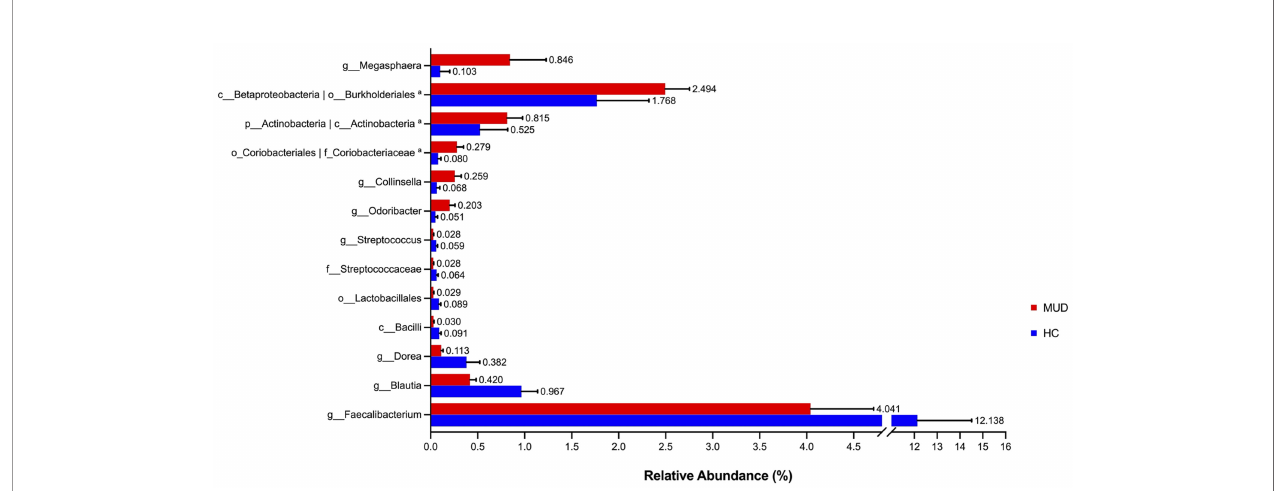
FIGURE 2 | Barplots for relative abundance of signi fi cantly different taxa identi fi ed by LEfSe in the two groups. The x-axis represents the means proportion of the taxa. Each bar shows mean ± SEM. a The taxa showed the same relative abundance at both taxa